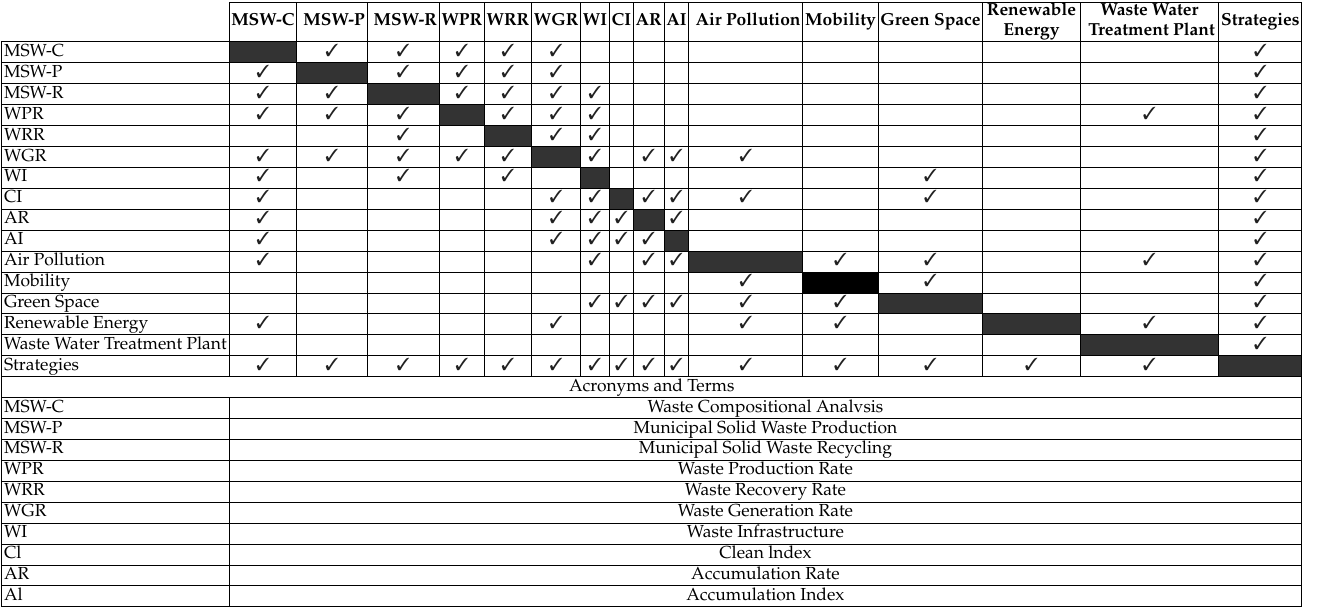
Table 14. Proposed Correlations between KPIs which will be defined through research at field and software such as lifecycle assessment, or other simulation